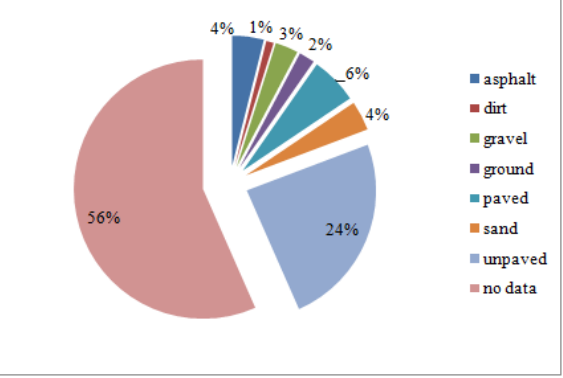
Figure 3. Pie chart of surfaces for Kenya's secondary roads